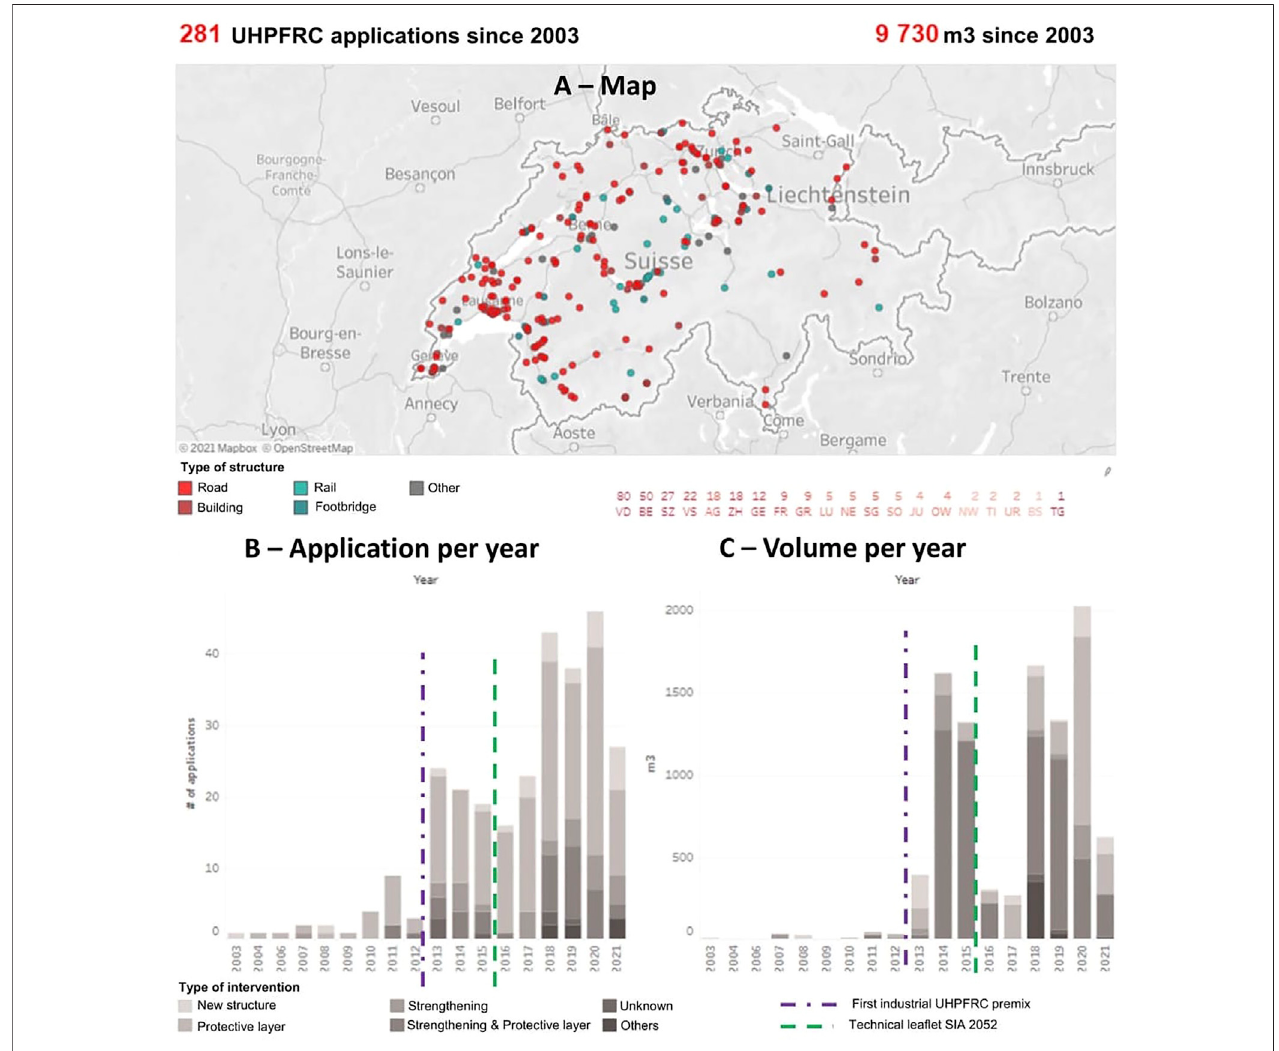
FIGURE 5 | (A) map of UHPFRC in Switzerland; (B) Histogram of applications per year; (C) Volume of UHPFRC used per year.